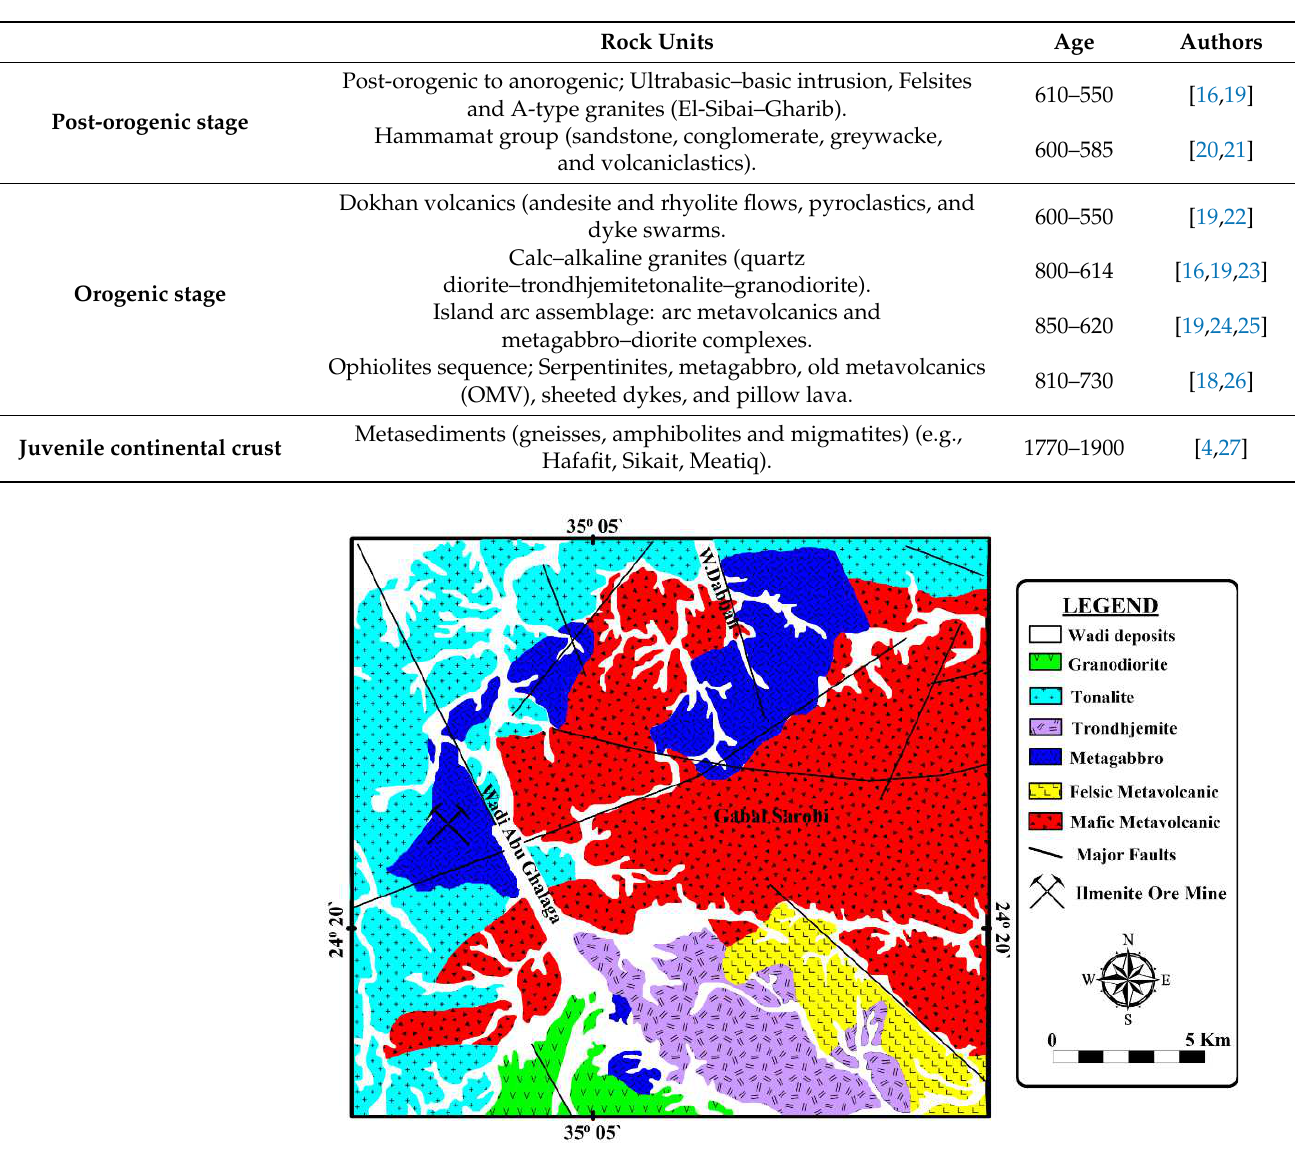
Table 1. Major tectonic events and geochronology of the Neoproterozoic basement complex of Egypt [16–18].